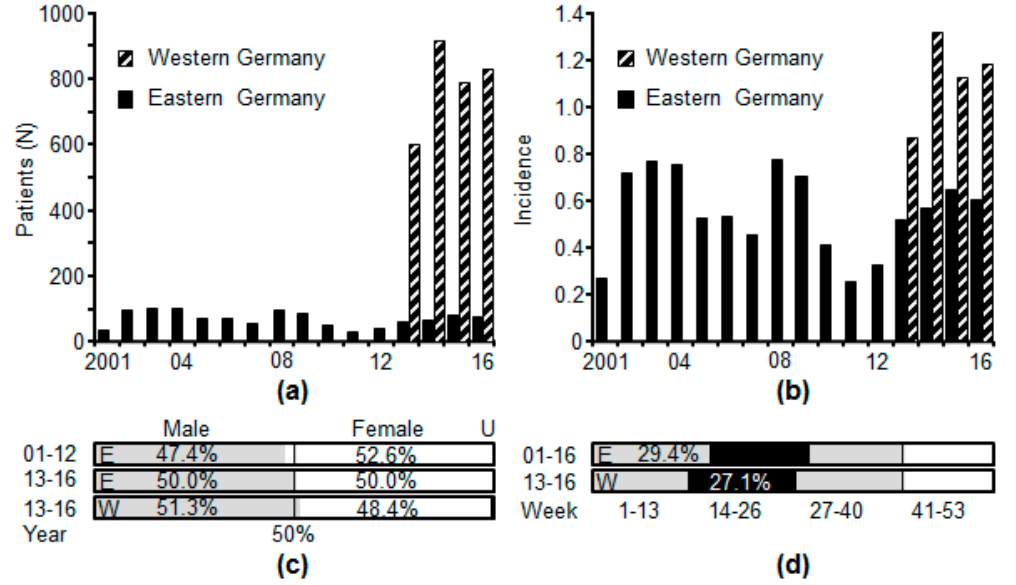
Figure 3. Notifications of mumps cases in Western and Eastern Germany 2001–2016. In Western Germany notification of mumps started in 2013 and in Eastern Germany in 2001. ( a ) Number of affected individuals. ( b ) Incidence (cases/100,000 persons). ( c ) Percentage of male and female patients. ( d ) Seasonal distributions of mumps notifications. E = Eastern Germany. W = Western Germany. U = Unknown sex. Data were obtained from the Survstat tool of the German Robert-Koch-Institute (RKI) [74]. Data were accessed on 12 April 2018. Eastern Germany comprised Brandenburg, Mecklenburg-Western Pomerania (Meckenburg-Vorpommern), Saxony, Saxony-Anhalt and Thuringa. The other 11 federal states including Berlin were regarded as Western